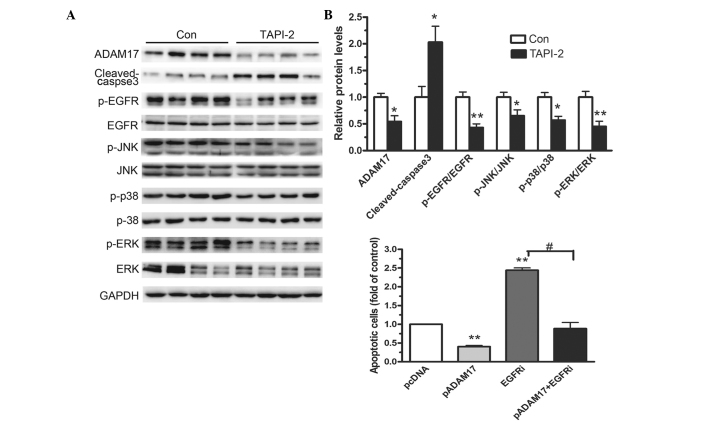
Involvement of the EGFR/MAPK signaling pathway in ADAM17-mediated cell survival. (A) Western blot analysis was performed to measure the expression levels of p-EGFR and p-MAPK in mice fed 2.2 mM TAPI-2 per day. (B) Flow cytometry bar graphs show the apoptotic ratio in microglial cells transfected with either an ADAM17-overexpressing vector, an empty vector or pre-incubated and treated with the EGFRi. The data are expressed as the mean ± standard deviation (n=3; *P<0.05 and **P<0.01, vs. Con; #P<0.05, vs. ADAM17+EGFRi. EGFR, epidermal growth factor receptor; MAPK, mitogen activated protein kinase; ADAM17, A disintegrein and metalloprotease 17; p-, phosphorylated; EGFRi, EGFR phosphorylation inhibitor (AG1478); Con, control; ERK, extracellular signal-regulated kinase; JNK, c-Jun N-terminal kinase; TAPI-2, TNF protease inhibitor 2.